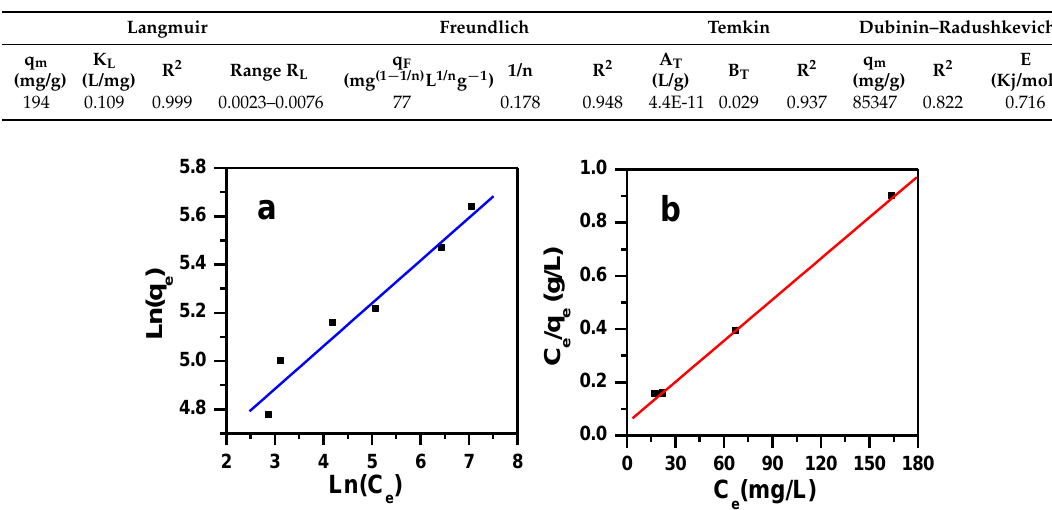
Table 3. Isotherm parameters for removal of MB using MNS-4.